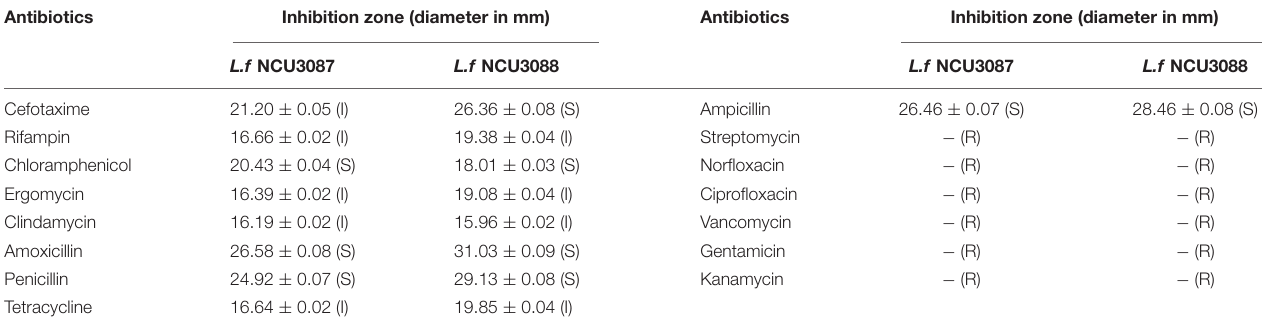
TABLE 2 | Antibiotic susceptibility of lactic acid bacteria. Antibiotics